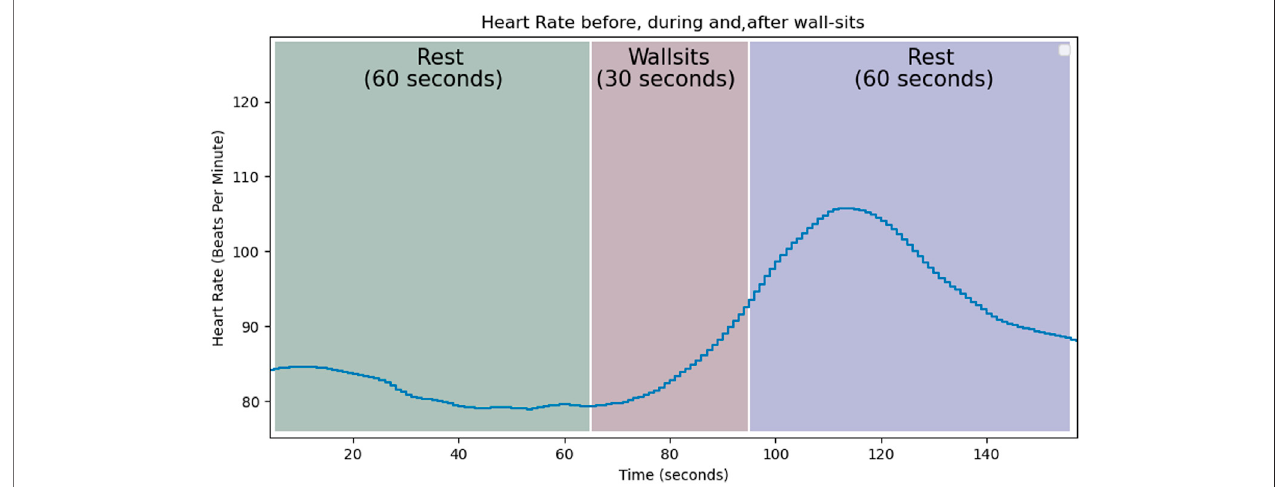
FIGURE12| Averageheart rateextracted from thePPGsignal during rest,wall sits andrest. Aclear increase inheartratecanbeobservedshortly after and during exercise. Heart rate continues to climb after exercise is fi nished due to a 30 s time window over which the average is calculated. Signals shown in this fi gure can be downloaded from Supplementary Datasheet S5 .